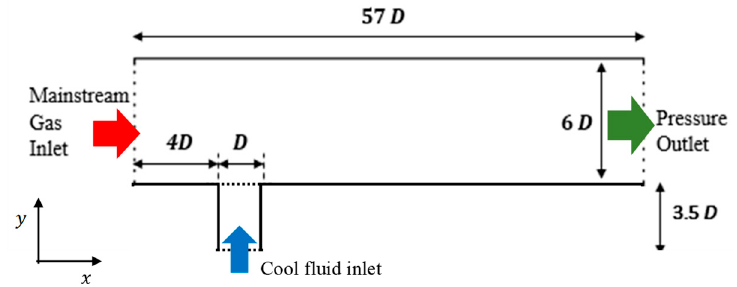
Figure 1. A schematic of the computational domain for 90 degree jet angle with hot inlet air from left-side, cool jet from bottom side and one outlet for the mixed flow.